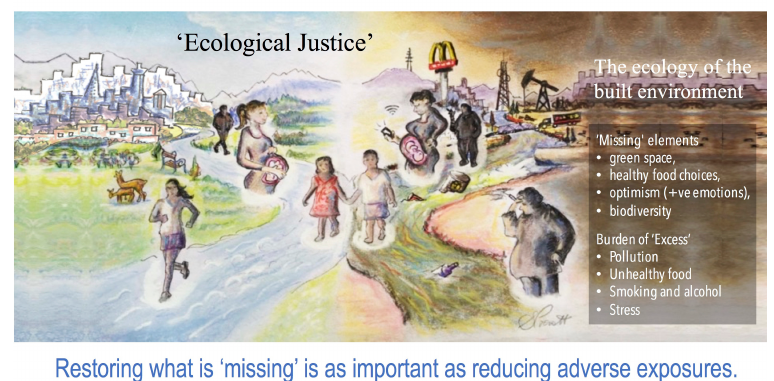
Figure 2. The Tale of Two Cities: Addressing the “upstream“ drivers of health and human potential. While individuals can influence their environment, the environmental effects on individuals (and their opportunities and choices) are much greater. These operate widely to influence both the health of environments and the health of individuals across